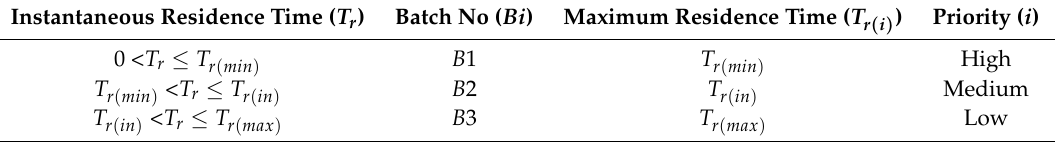
Table 1. Batch selection and